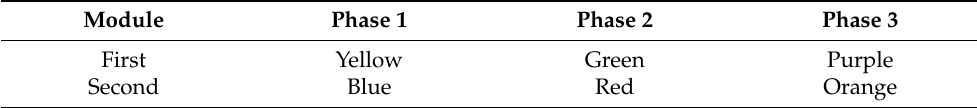
Table 2. Oscilloscope color for each module.